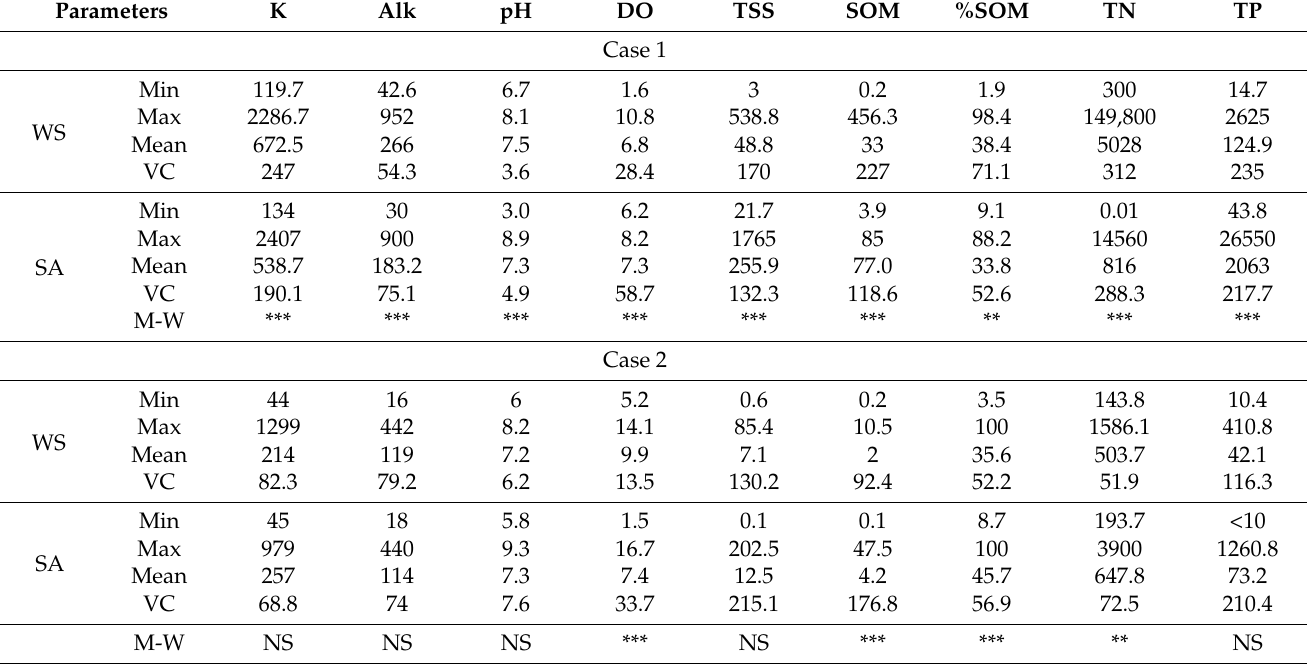
Table 2. Minimum (Min), maximum (Max), mean values, and variation coefficient (VC) as a percentage of physical–chemical parameters’ variations: conductivity (K, µ S/m), pH, dissolved oxygen (DO, mg/L), alkalinity (Alk, mg CaCO3/L), total suspended solids (TSS, mg/L), suspended organic matter (SOM, mg/L), total nitrogen (TN, µ g/L), total phosphorus (TP, µ g/L). The statistical significance of the Mann–Whitney test is included, comparison between both periods of the year monitored. NS: non-significant, ** significant, p < 0.01, *** significant, p <